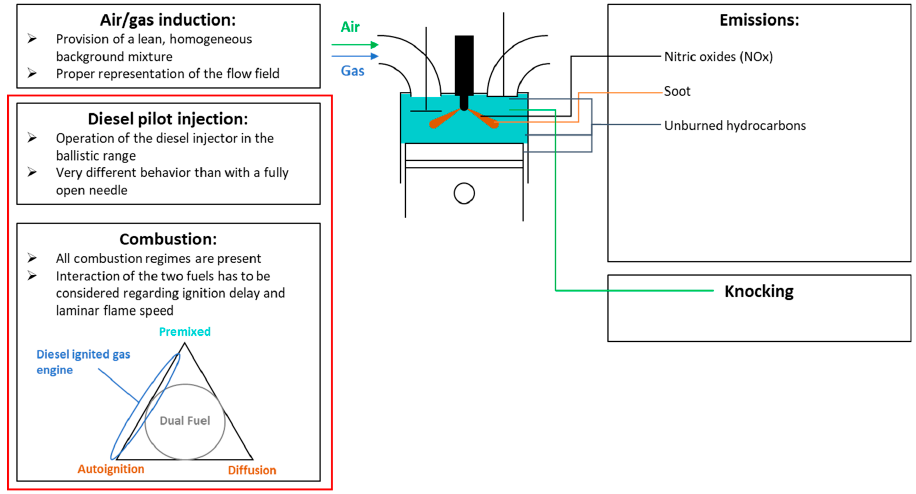
Figure 1. Numerical challenges for the 3D-CFD simulation of a dual fuel engine. The combustion regimes encountered are shown in the triangle. The red rectangle shows the focus of this paper.